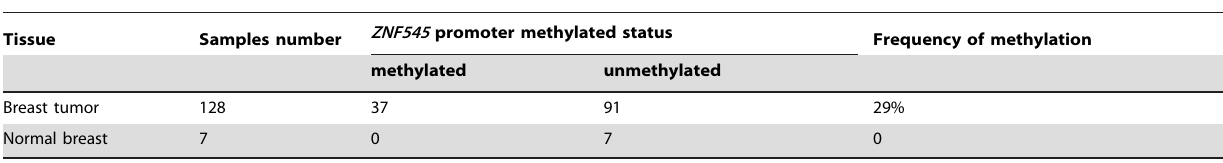
Table 4. Promoter methylation status of ZNF545 in primary breast tumors.